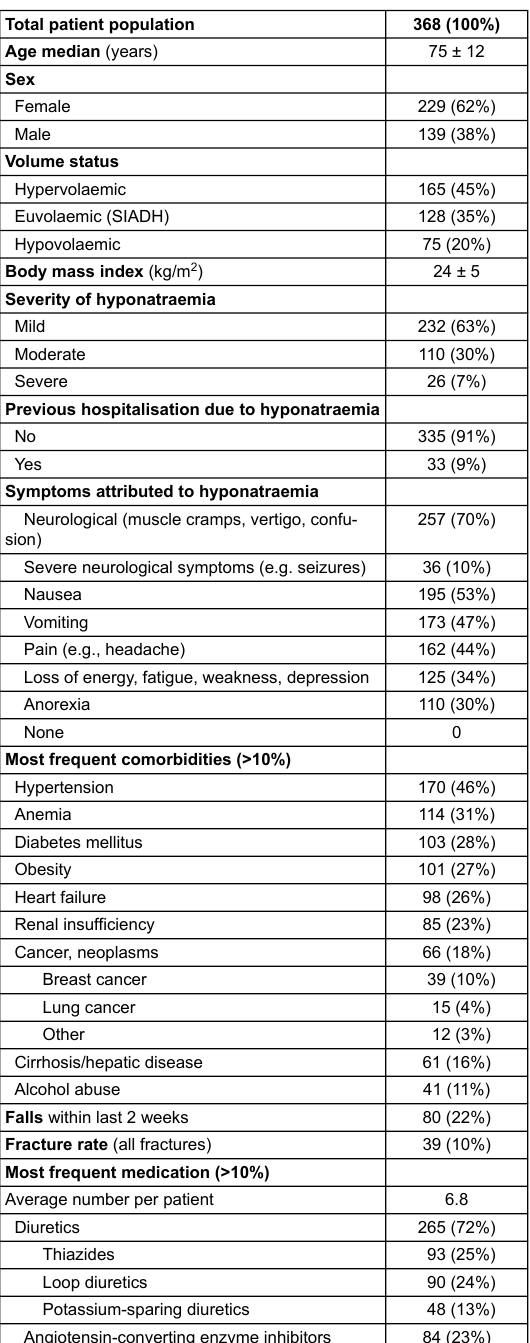
Table 1: Patient